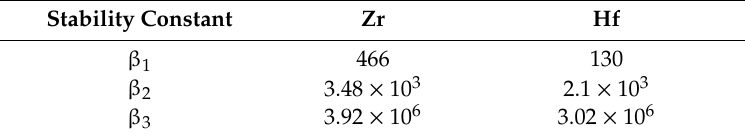
Table 2. Stability constants of sulphate complexes of zirconium and